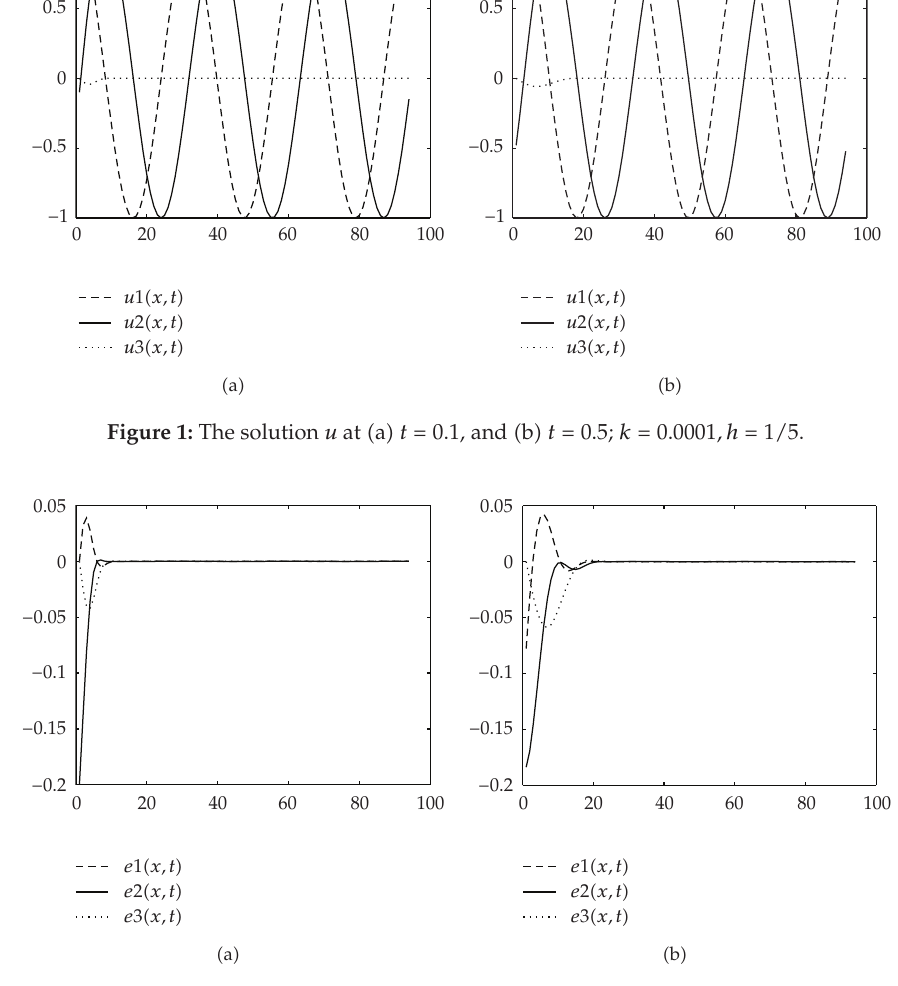
Figure 2: The error of u at (cid:3) a (cid:4) t (cid:7) 0 . 1 and (cid:3) b (cid:4) t (cid:7) 0 . 5; k (cid:7) 0 . 0001 ,h (cid:7) 1 /